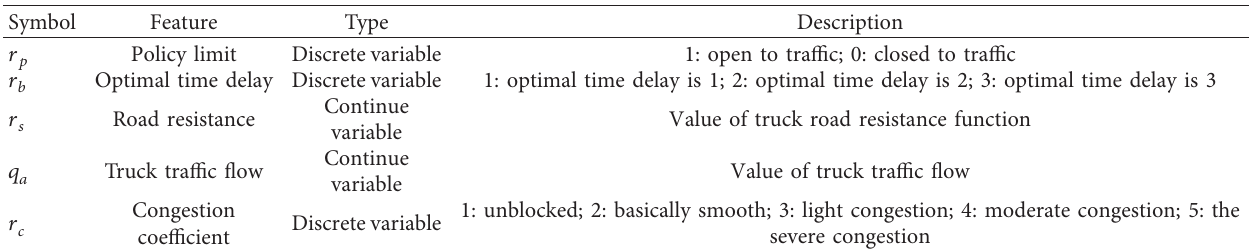
Figure 2: Schematic diagram of time delay. Table 2: The details of the variable